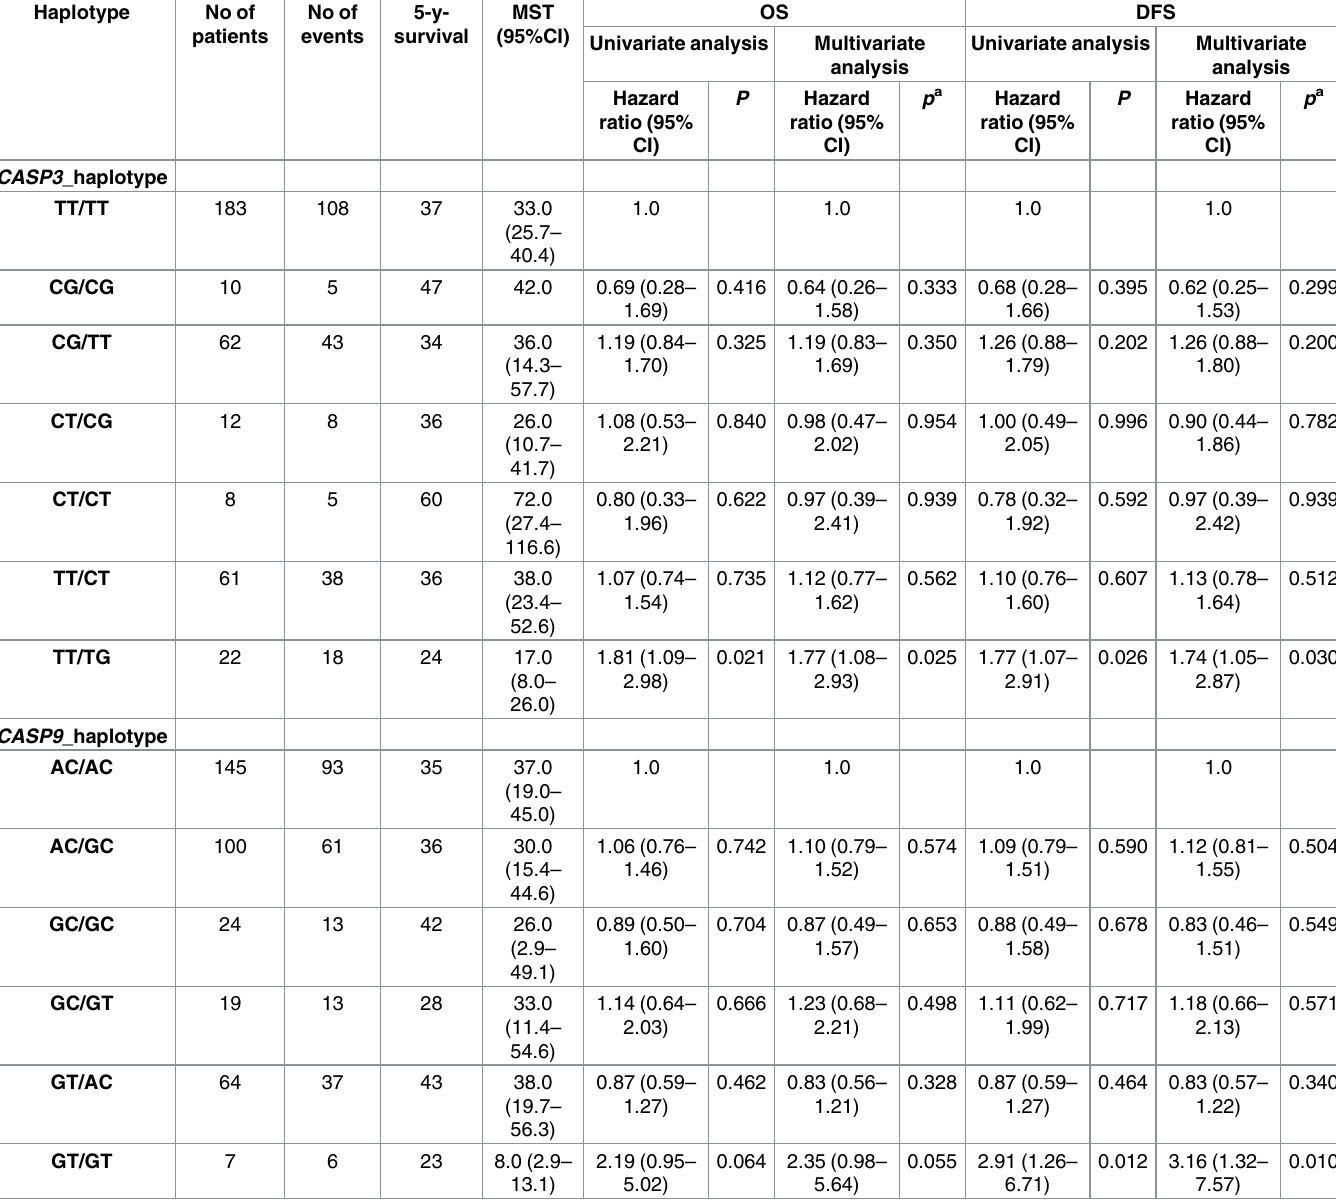
Table 4. Univariate and multivariate Cox regression analysis of haplotypes in HCC patients.